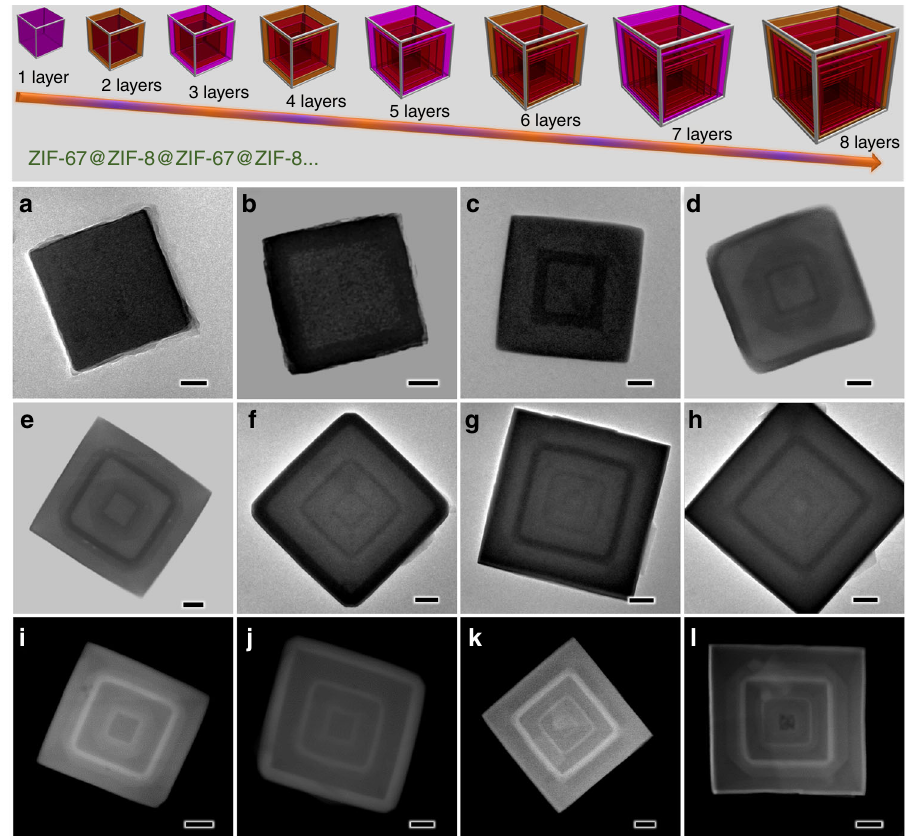
Fig. 2 TEM and HAADF-STEM analysis of nano-Matryoshka structured ZIFs. a ZIF-67, b ZIF-67@ZIF-8, c tri-layered ZIF, d tetra-layered ZIF, e , i penta- layered ZIF, f , j hexa-layered ZIF, g , k hepta-layered ZIF, and h , l octa-layered ZIF. The top panel illustrates the synthetic strategy for Matryoshka-type (ZIFs@) n − 1 ZIFs with their 3-dimensional geometrical models. Colour code in the models: purple represents ZIF-67 and brown represents ZIF-8. Scale bars in a – l are 40, 60, 100, 100, 150, 200, 300, 300, 200, 200, 300 and 300 nm,